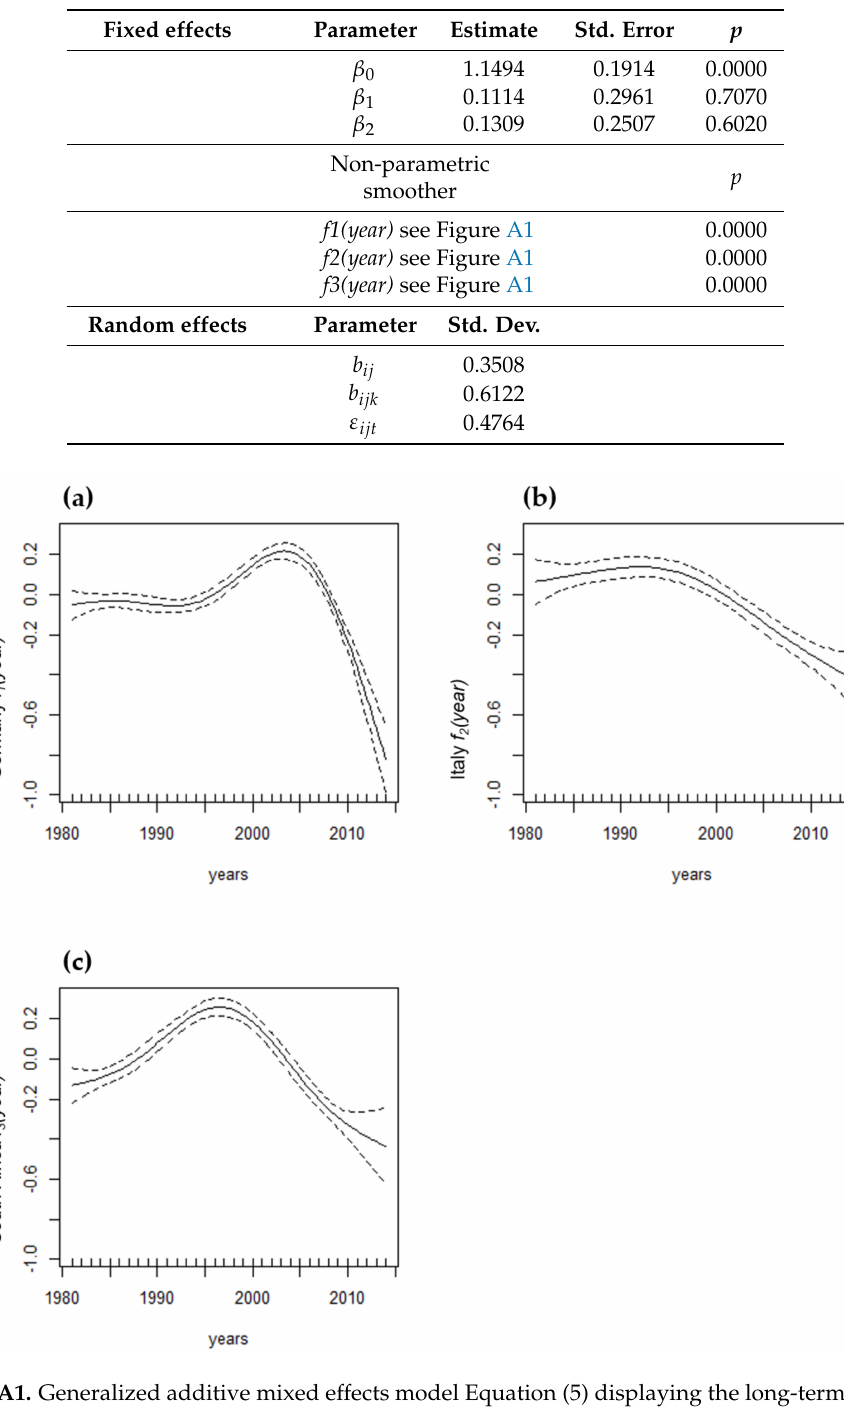
Table A3. Model parameters for the generalized additive mixed effects model Equation (5) displaying the long-term growth behaviour and recent growth trends (Figure 6). Parameter estimates for each experiment’s fixed effects with standard errors (Std. Error) and significances ( p ) and the standard deviation (Std. Dev.) of random effects. The non-parametric smoothers as function of the calendar year are added to the fixed effects and are displayed in Figure A1 in the Appendix A.